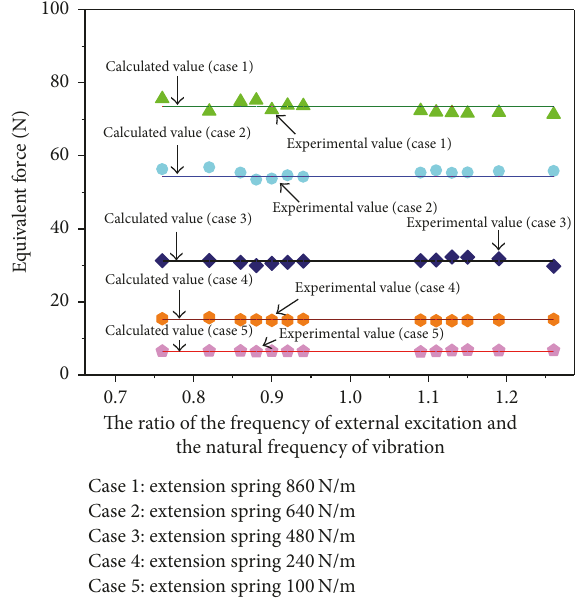
Figure 6: Comparison of equivalent forces with different extension springs and